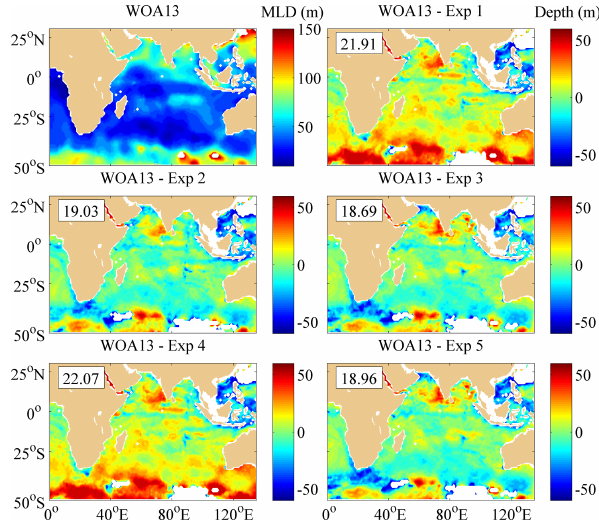
Figure 12. The distribution of the MLD calculated from WOA13 data and the differences of the MLD between the WOA13 data and the results simulated in Exp 1–Exp 5. RMSEs of the MLD are shown in the upper left corner of the panels. Deep yellow and white areas correspond to land, and the calculated MLDs are deeper than